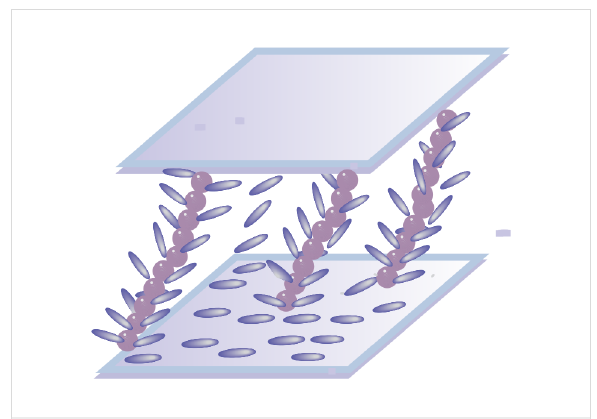
In pure nematic substances, the relaxation time τ off does not depend on the applied field as long as it is higher than the Fréedericksz transition threshold. As it can be observed from Table 1, when ferro-particles are added, the relaxation time decreases with increase of the applied